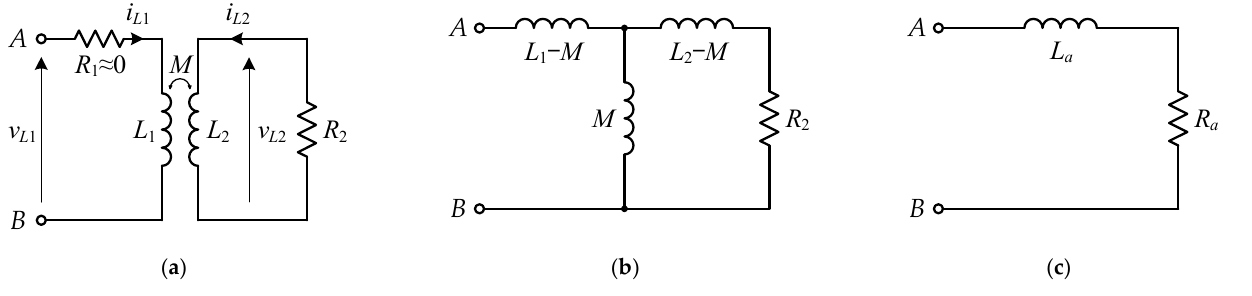
Figure 1. Induction heating fixed roller for copy and printing machines. ( a ) Sectional view. ( b ) Internal configuration. ( c ) Toner fixing process.